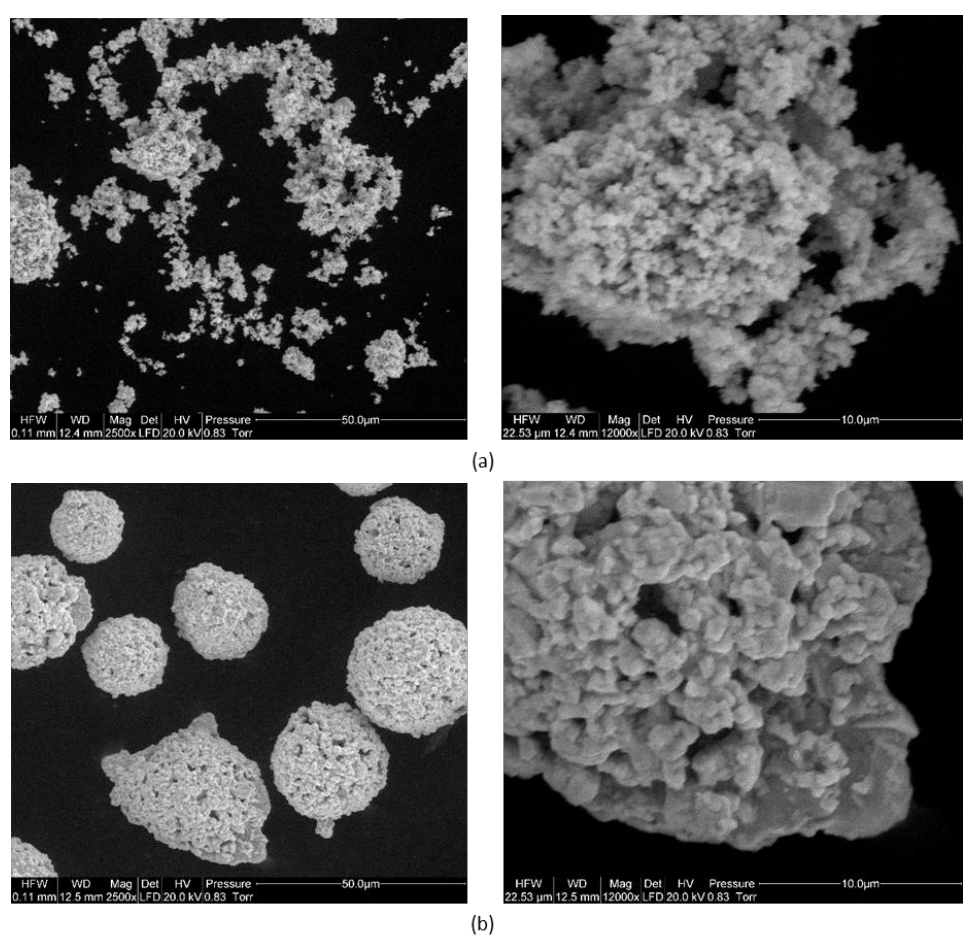
Figure 1. SEM images of powders used to prepare sinters: ( a ) primary particle size of WC about 1 μm (submicron); ( b ) primary particle size of WC approx. 400 nm (ultrafine).